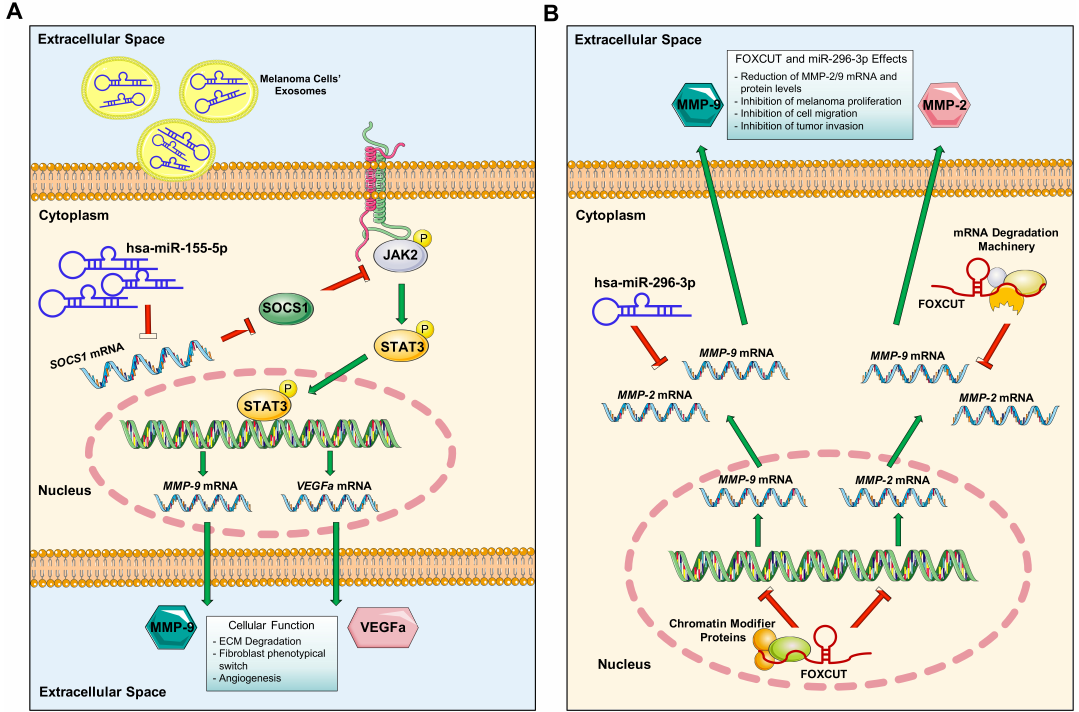
Figure 2. Epigenetic regulation of MMP-9 in melanoma. ( A ) Melanoma cells secrete exosomes containing di ff erent proteins and ncRNAs, including hsa-miR-155-5p. These exosomes are internalized by cells of the tumor microenvironment, such as fibroblasts. Inside the cells the exosomal hsa-miR-155-5p is able to inhibit SOCS1 mRNA thus activating the JAK / STAT molecular pathway. Phosphorylated STAT3 binds the DNA inducing the transcription of MMP-9 , VEGFa and other pro-angiogenetic factors (e.g., FGF2 ). These proteins will be responsible for ECM degradation, fibroblasts switch to cancer-associated fibroblast phenotype and neoangiogenesis; ( B ) ncRNAs may act also as inhibitors of MMP-9 and MMP-2 . In particular, hsa-miR-296-3p is able to inhibit both MMP-9 and MMP-2 mRNA thus reducing their secretion in the extracellular space. Similarly, FOXCUT lncRNA is able to inhibit MMP-2 and MMP-9 transcription and translation into proteins. Both ncRNAs are responsible of the inhibition of melanoma cell proliferation, migration and